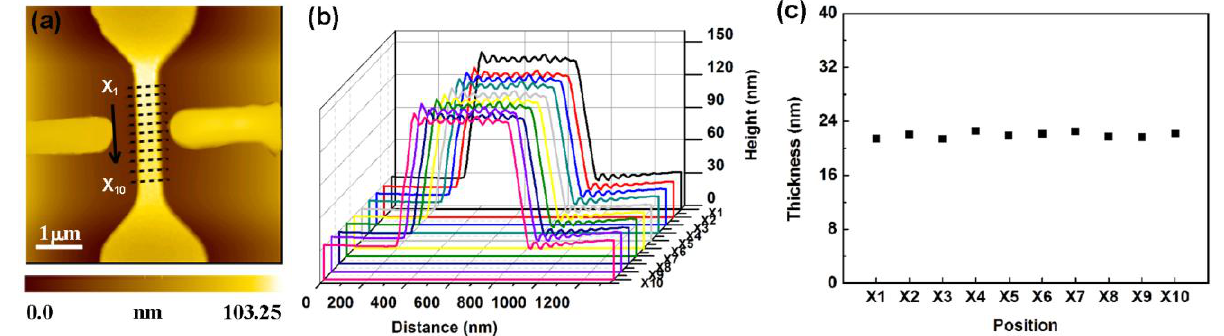
Figure 5. Membrane thickness variations for different positions on a single PSW using FIB processed C-AFM tip